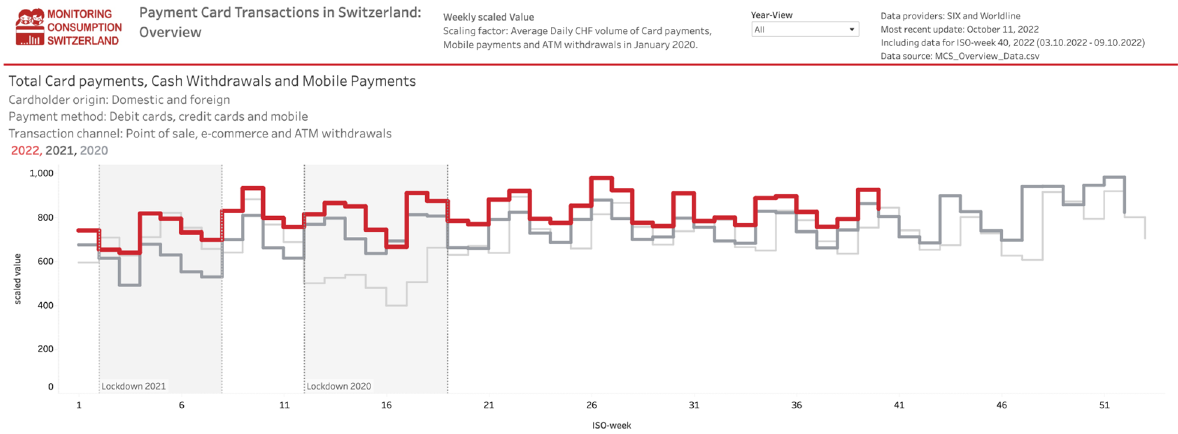
Fig. 2 Example of data visualization. Note : The figure illustrates the development of consumer spending (debit & credit cards, mobile payments and ATM withdrawals) in 2020 (light gray), 2021 (dark gray) and 2022 (red). The data are aggregated on a weekly basis (see stair pattern). The first (spring 2020) and second (spring 2021) lockdowns are marked with shading. We display the data as provided, i.e., as a scaled value, which cannot be interpreted in its own right but which preserves the relative interpretability both over time and in the cross-section. See Sect. 2 for the details on the scaling. The most recent version of this (interactive) dashboard is available on the project website (see dashboard “Payment Card Transactions in Switzerland: Overview”). Data source: